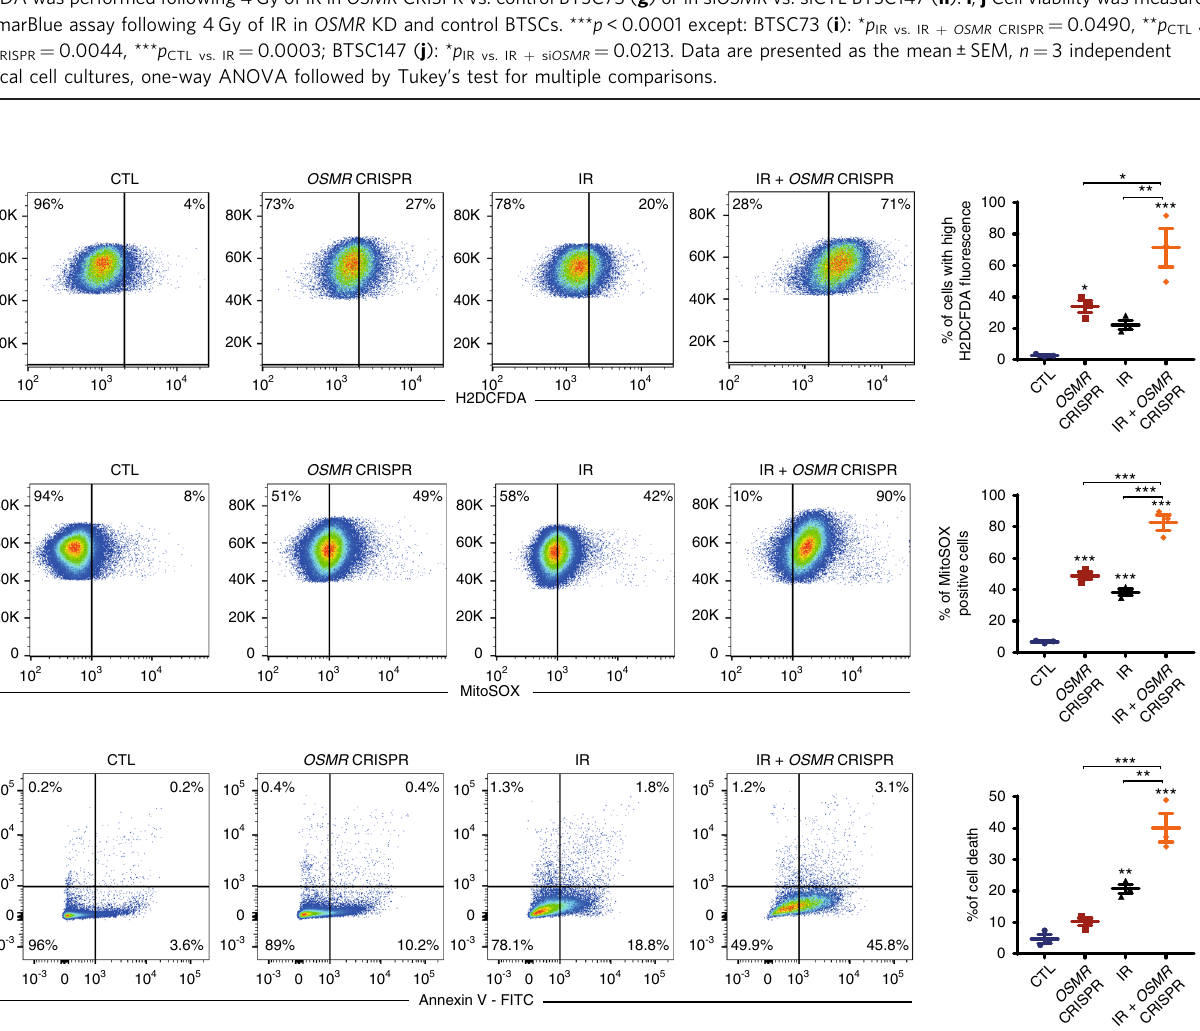
Fig. 5 OSM/OSMR confers resistance of BTSCs to IR. a , b LDA was performed following 4 Gy of IR in the absence or presence of OSM. BTSC73 ( a ): 200